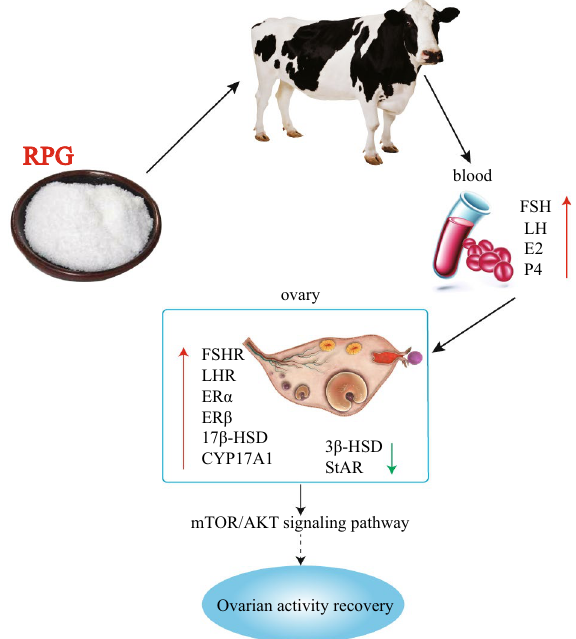
Figure 8. The schematic diagram for RPG improving the ovarian activity recovery in post-natal dairy cows. RPG addition might promote FSH, LH, E2, and P4 binding to their respective receptors, thereby activating the mTOR/AKT signaling pathway and accelerating ovarian activity recovery in post-calving dairy